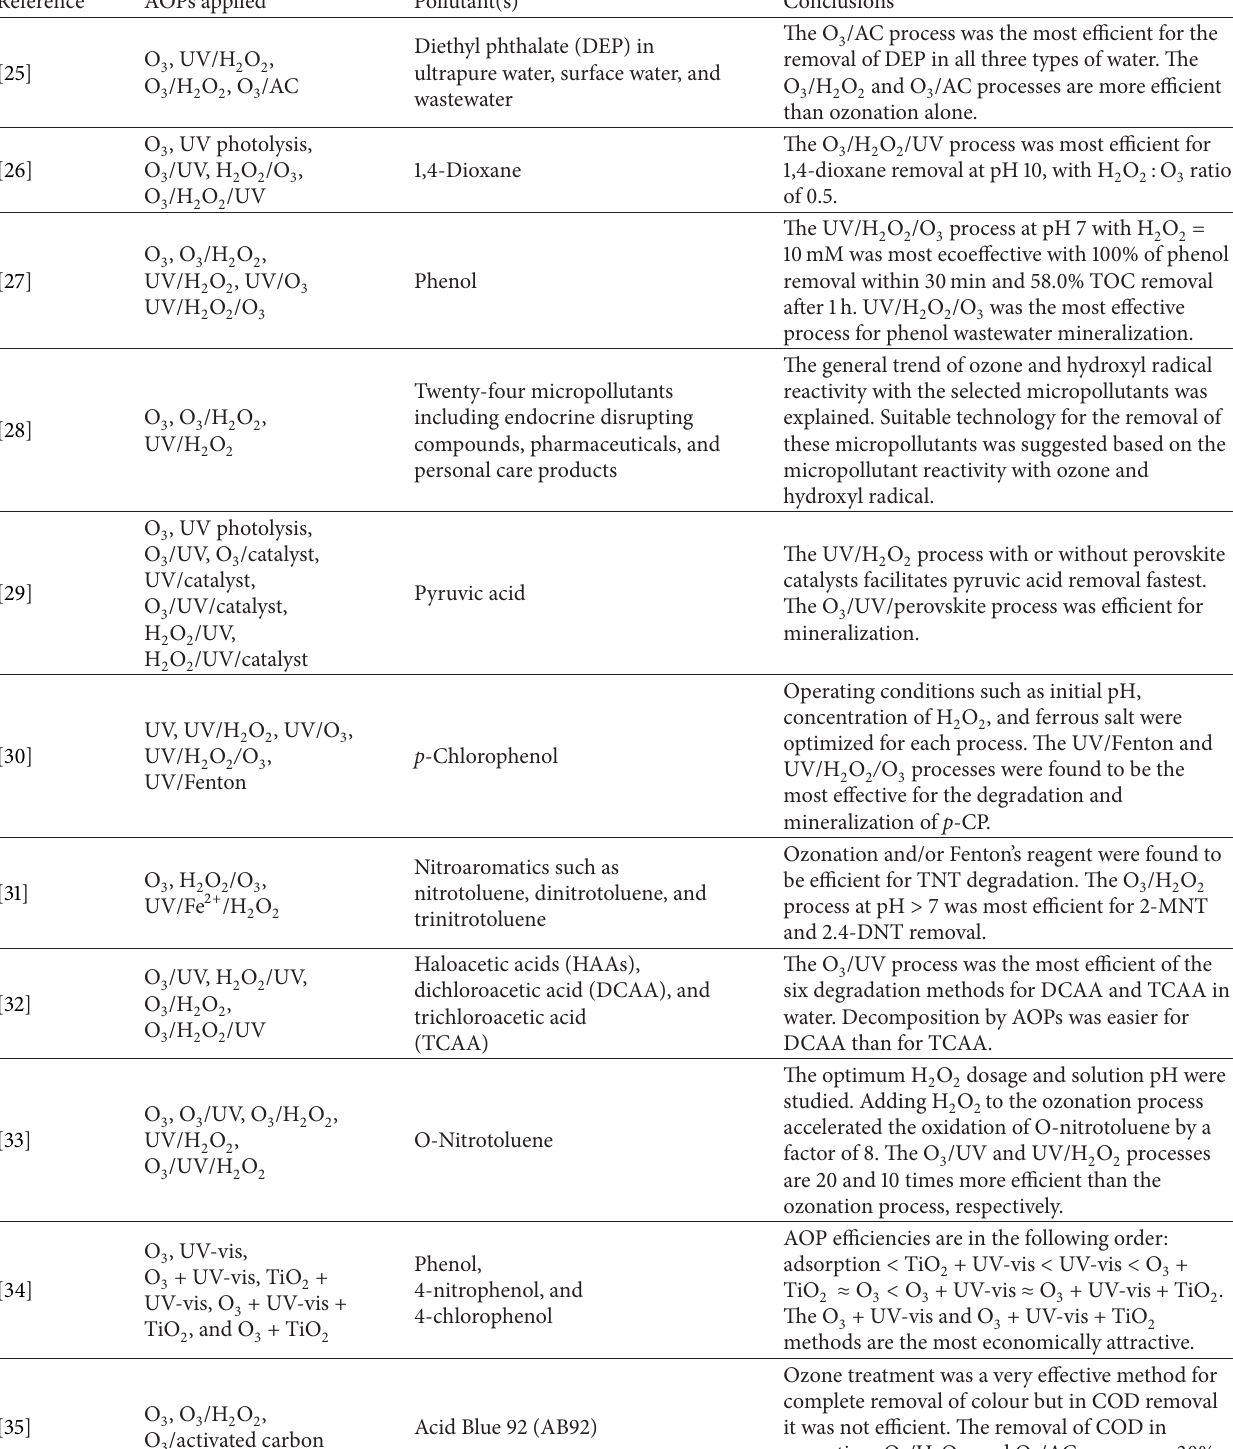
Table 2: Degradation of some model pollutants by ozone based AOPs under different experimental